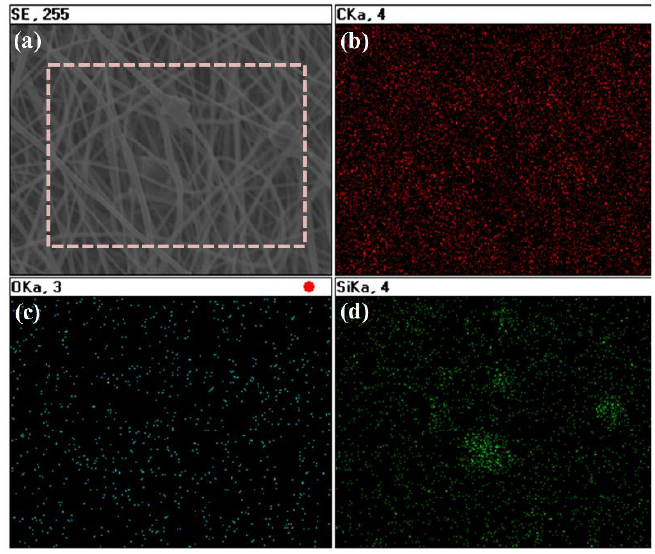
Figure 4. EPMA of ( a ) designated section of POSS-grafted PU nanomatrix demonstrating spatial distribution of elements ( b ) carbon, ( c ) oxygen, and ( d ) silicon.